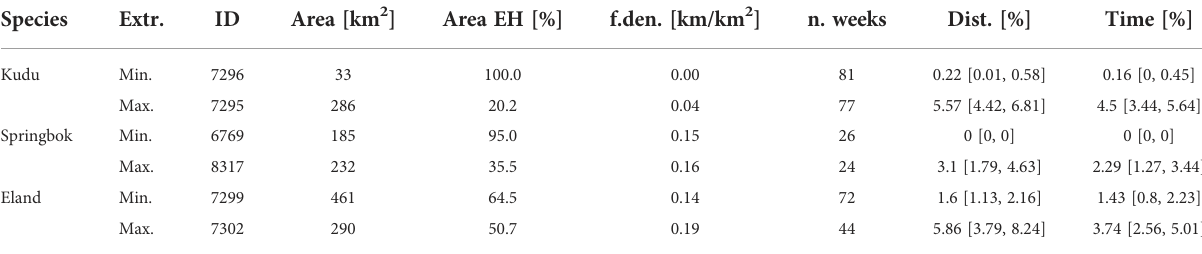
TABLE 1 Species-speci fi c extrema (extr. with minimum — min. and maximum — max.) of average weekly percentage of distance (dist.) and time at fence lines. Species Extr.